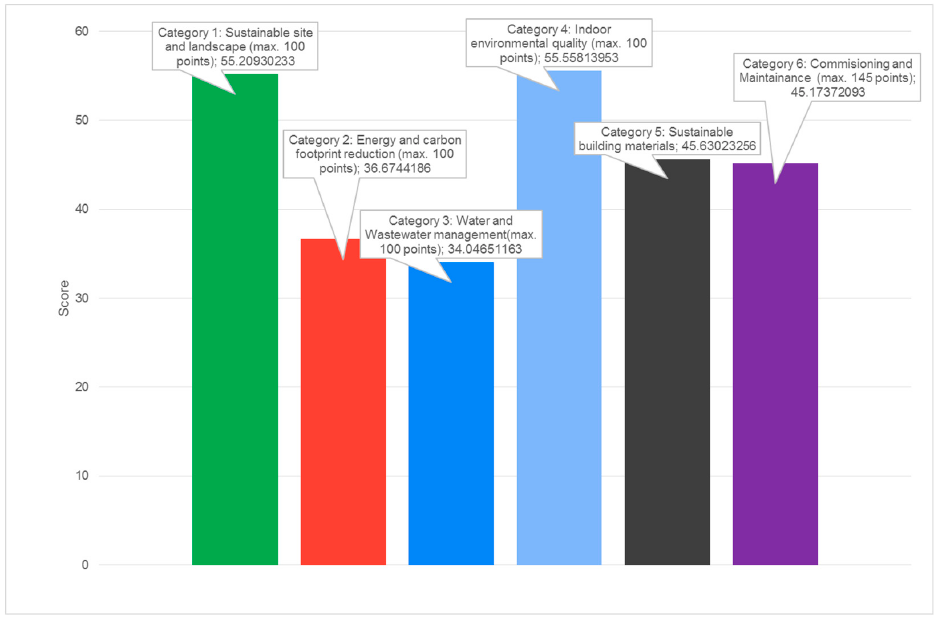
Figure 3. The average scores for each category.